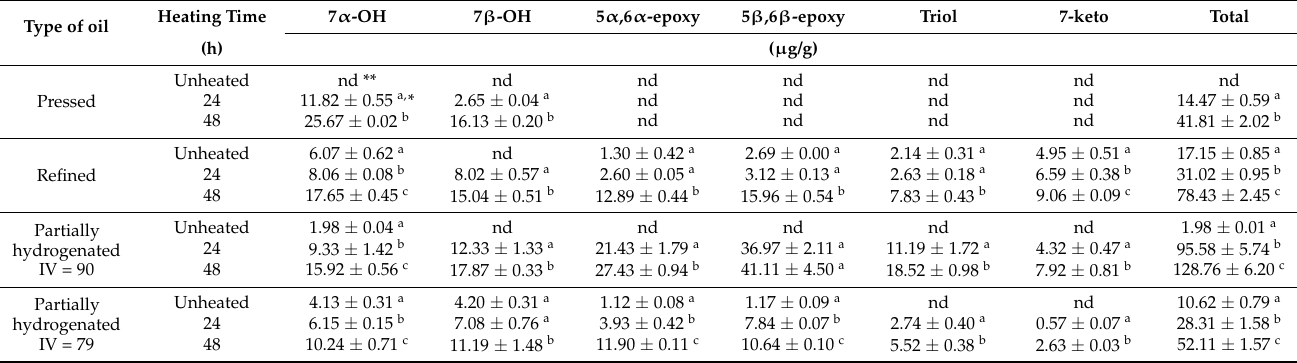
Values are means of three determinations ± SD. * Means in the same column followed by different letters indicate significant differences ( p < 0.05) between samples of each type of oil. ** nd—not